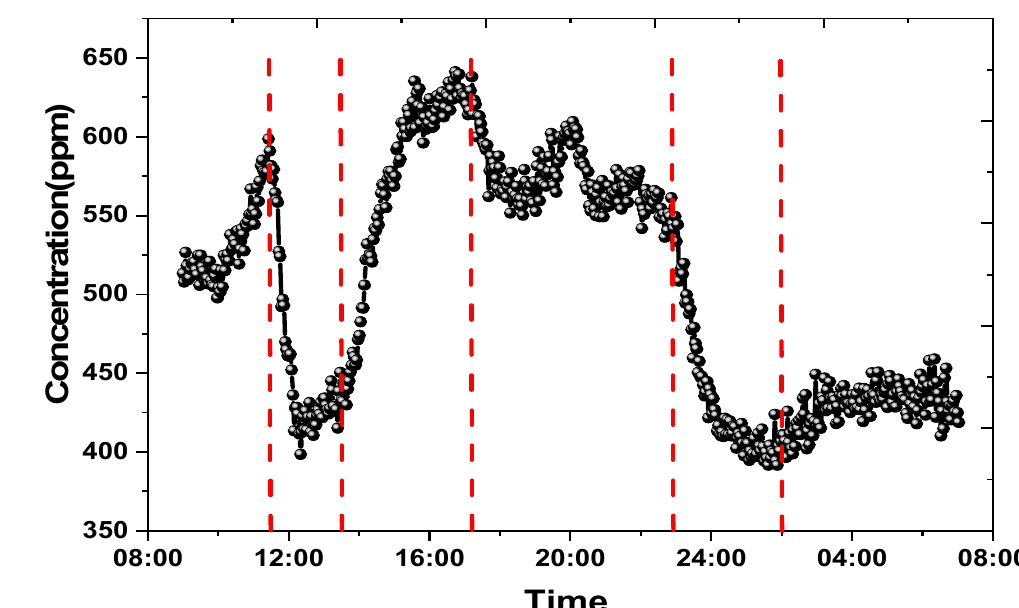
Figure 10. The variation of indoor CO 2 concentration is measured by the device over time. Continuous measurement for 22 h. The red vertical line marks several representative time nodes. There is a large turnover of people nearby, and CO 2 changes significantly.